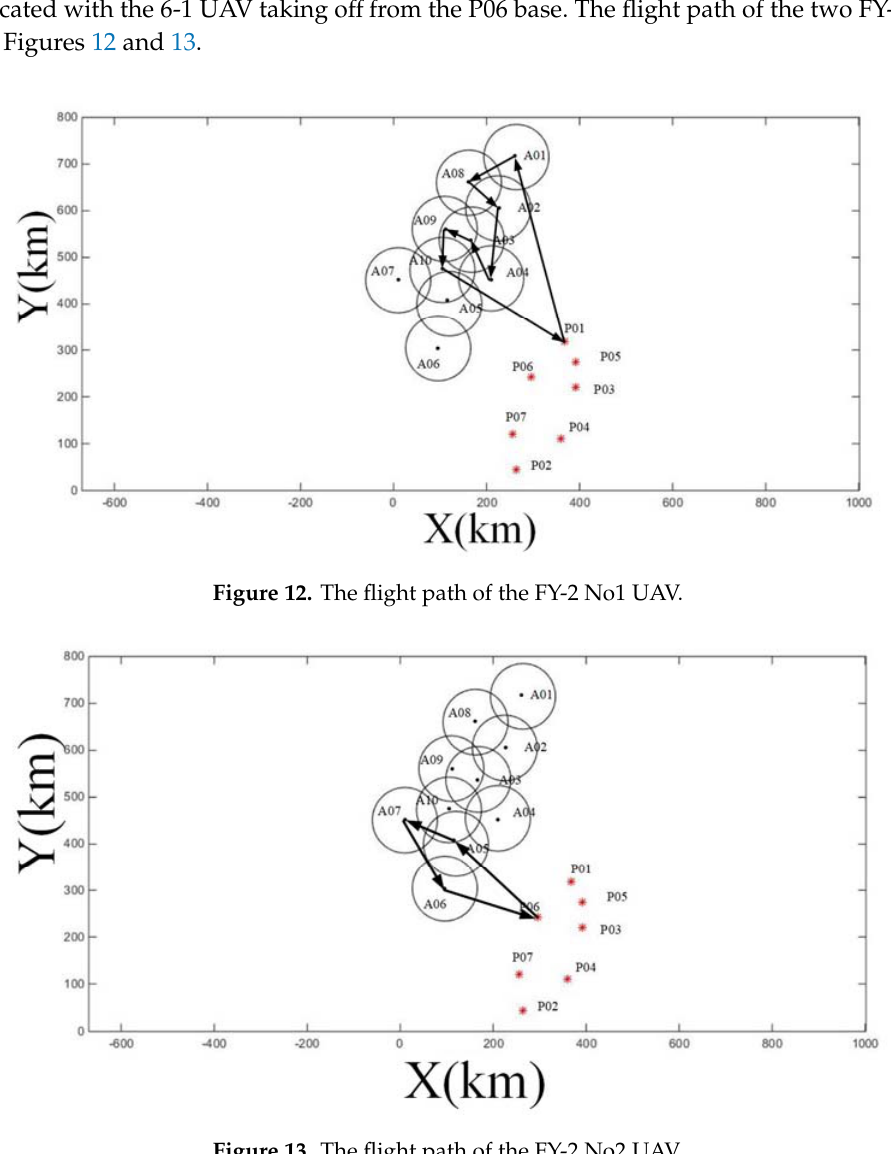
Table 6. The cooperative strategy of UAVs for communication.